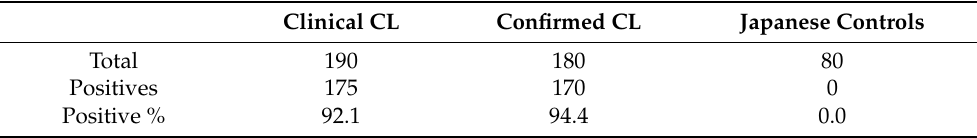
Table 2. Anti-rKRP42 IgG seropositive rates among CL cases and Japanese controls.